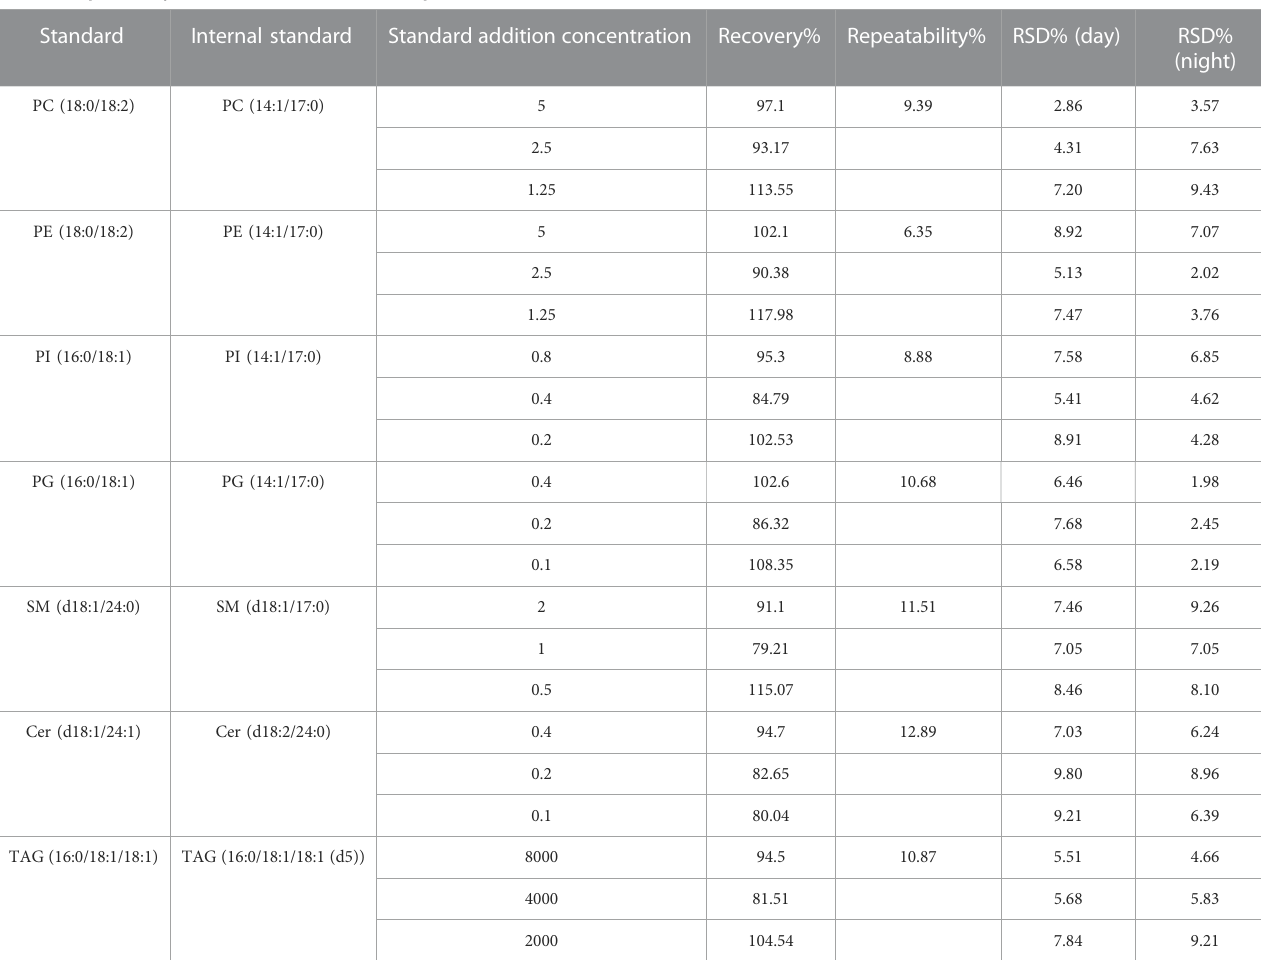
TABLE 4 Repeatability (RSD, %) of standards and